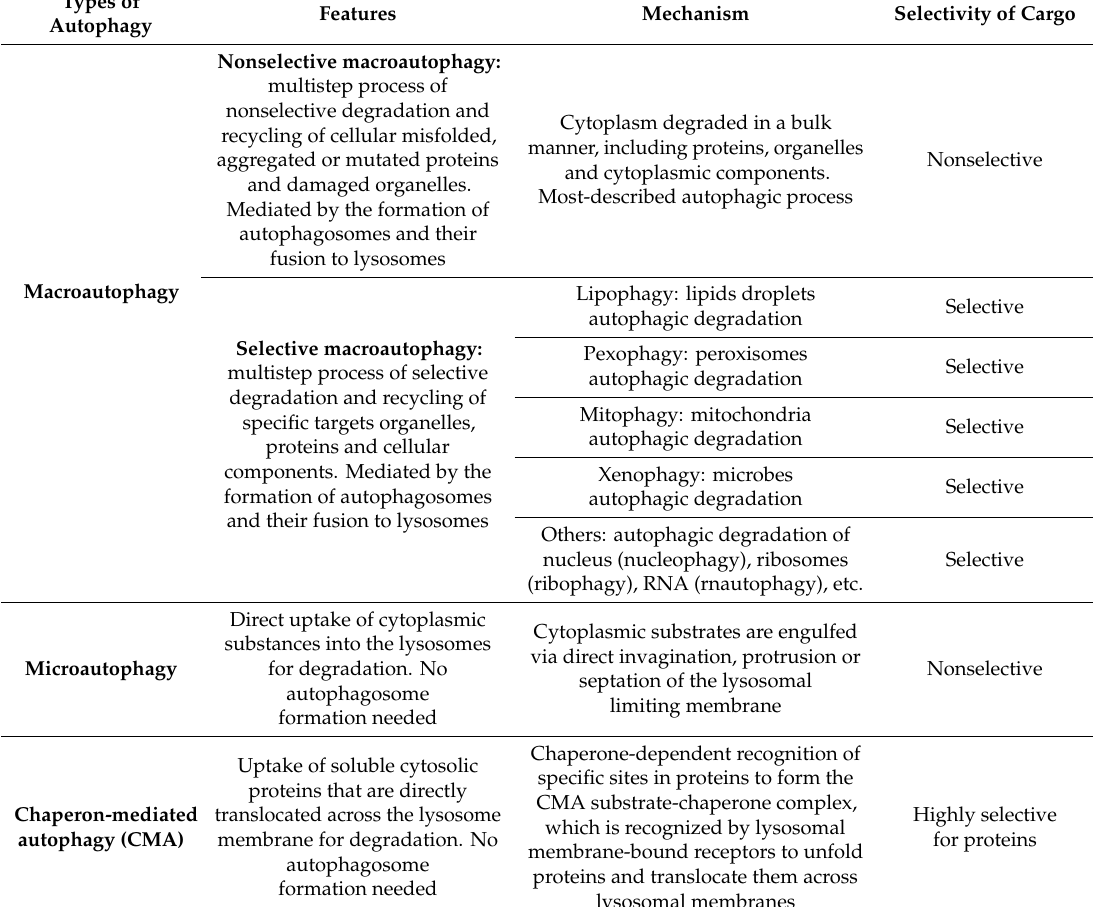
Table 1. Main types of